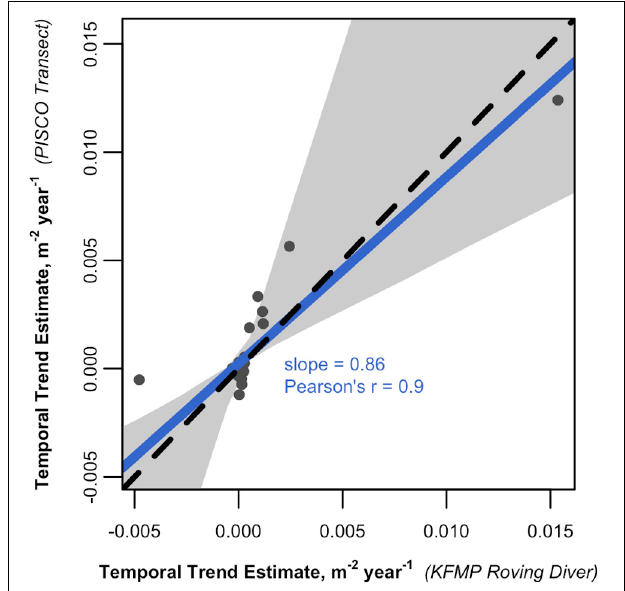
FIGURE 7 | Scatterplot comparing the relationship between time and fish densities estimated from KFMP roving diver counts to those calculated from PISCO transect data. Each point is the coefficient for the effect of time from a linear mixed effects model between date, site and the density of a species observed by both programs within the region ( n = 44; many dots are concentrated near the 0:0 point). The solid line represents a Deming linear regression and the dashed line represents the 1:1 line. The 0.95 confidence bounds are calculated with the bootstrap (quantile)